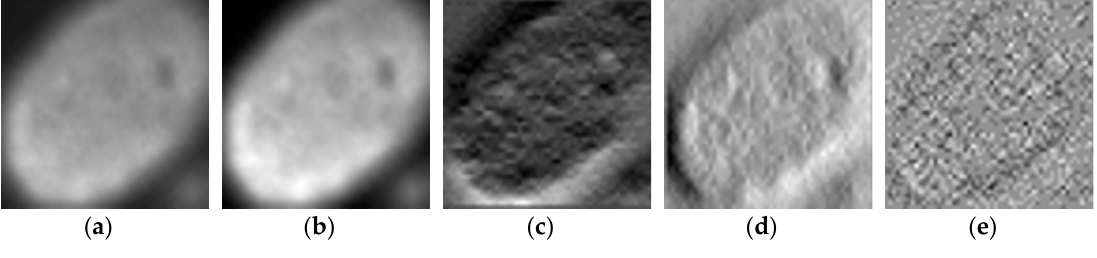
Figure 3. Positive intensity Fine Speckled cell. ( a ) Original image; ( b ) the approximation; ( c ) the horizontal detail; ( d ) the vertical detail; and ( e ) the diagonal detail. The original image has a size of 112 × 112. The outputs of the DWT are all downsized by half (56 × 56). All the images in the figure were identically resized for the purpose of visualization.